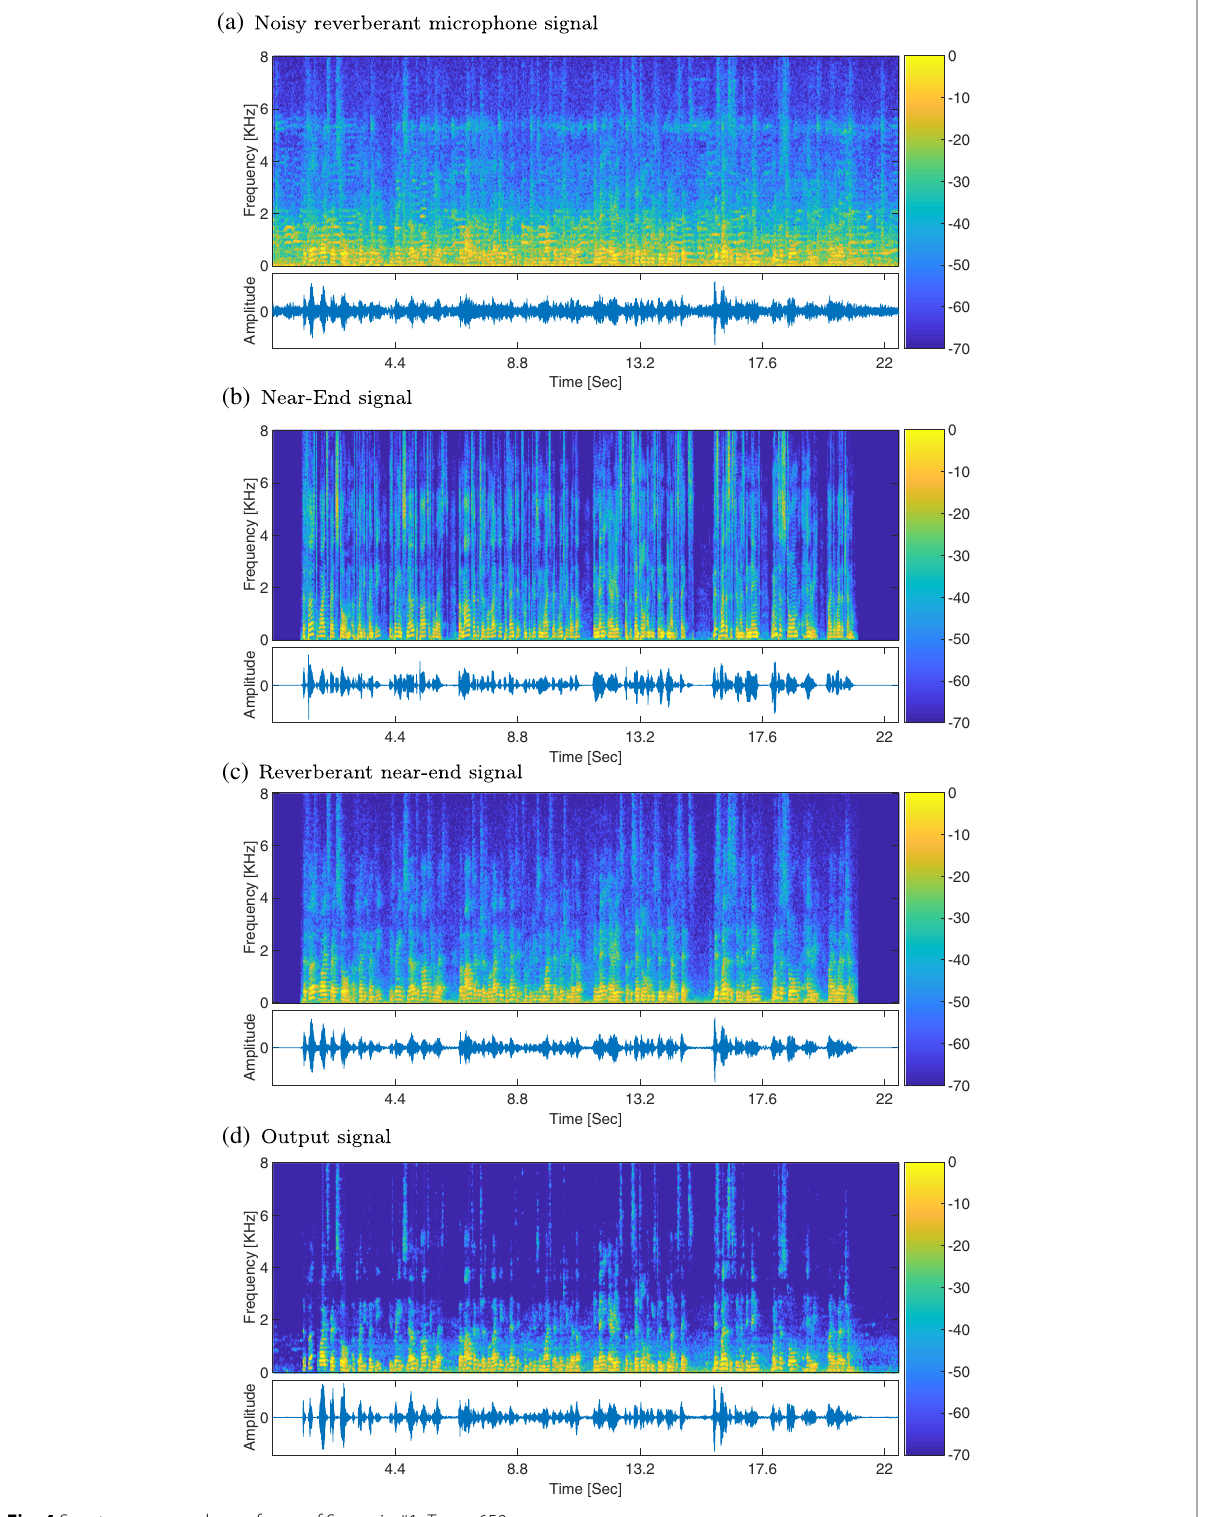
Fig. 4 Spectogrames and waveforms of Scenario #1, T 60 = 650